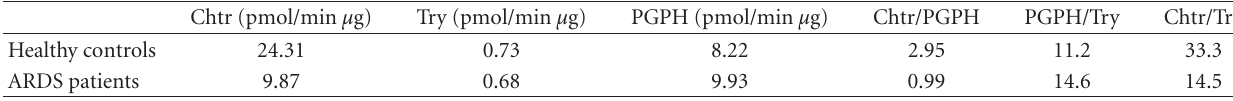
Table 2: Specific activities of proteasomes isolated from healthy controls and ARDS patients.